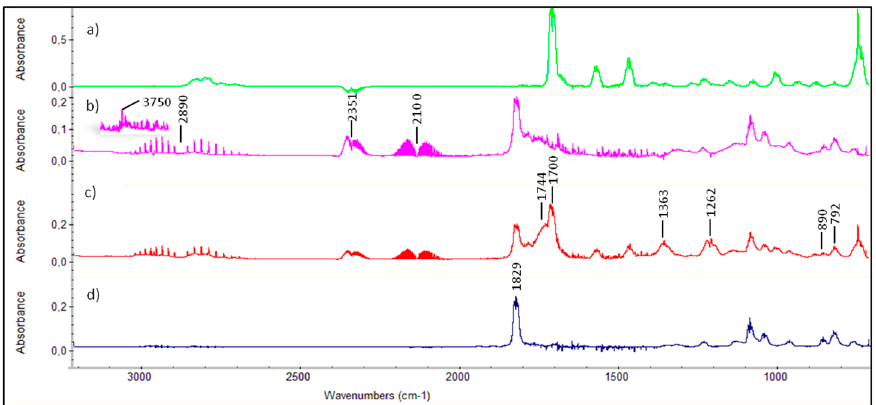
Figure 1. ( a ) FTIR spectra of furfural. ( b ) Furfural with chlorine atoms after 30 min of reaction. ( c ) furfural with chlorine atoms in the presence of NO after 20 min of reaction. ( d ) 5-chloro-2-(5 H )-furanone.